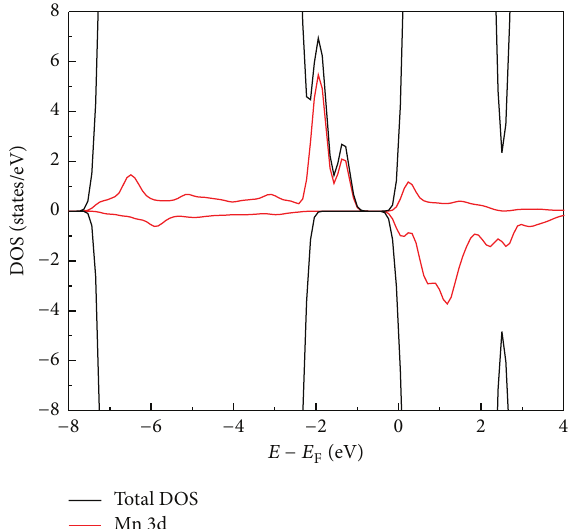
Figure2:Spin-resolvedtotaldensityofstatesfortheMncodopedTiO 2 incombinationwithanoxygenvacancyandspin-andorbital-resolved PDOS for the doped Mn